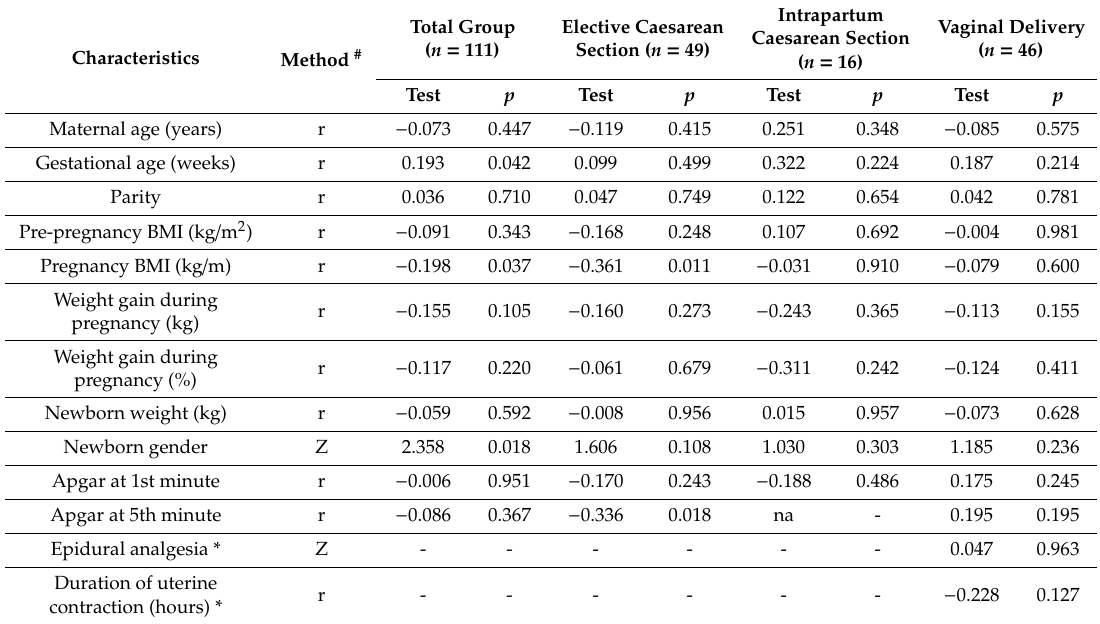
Table 2. Correlations between placental 11 β -HSD 2 and maternal or o ff spring outcomes.